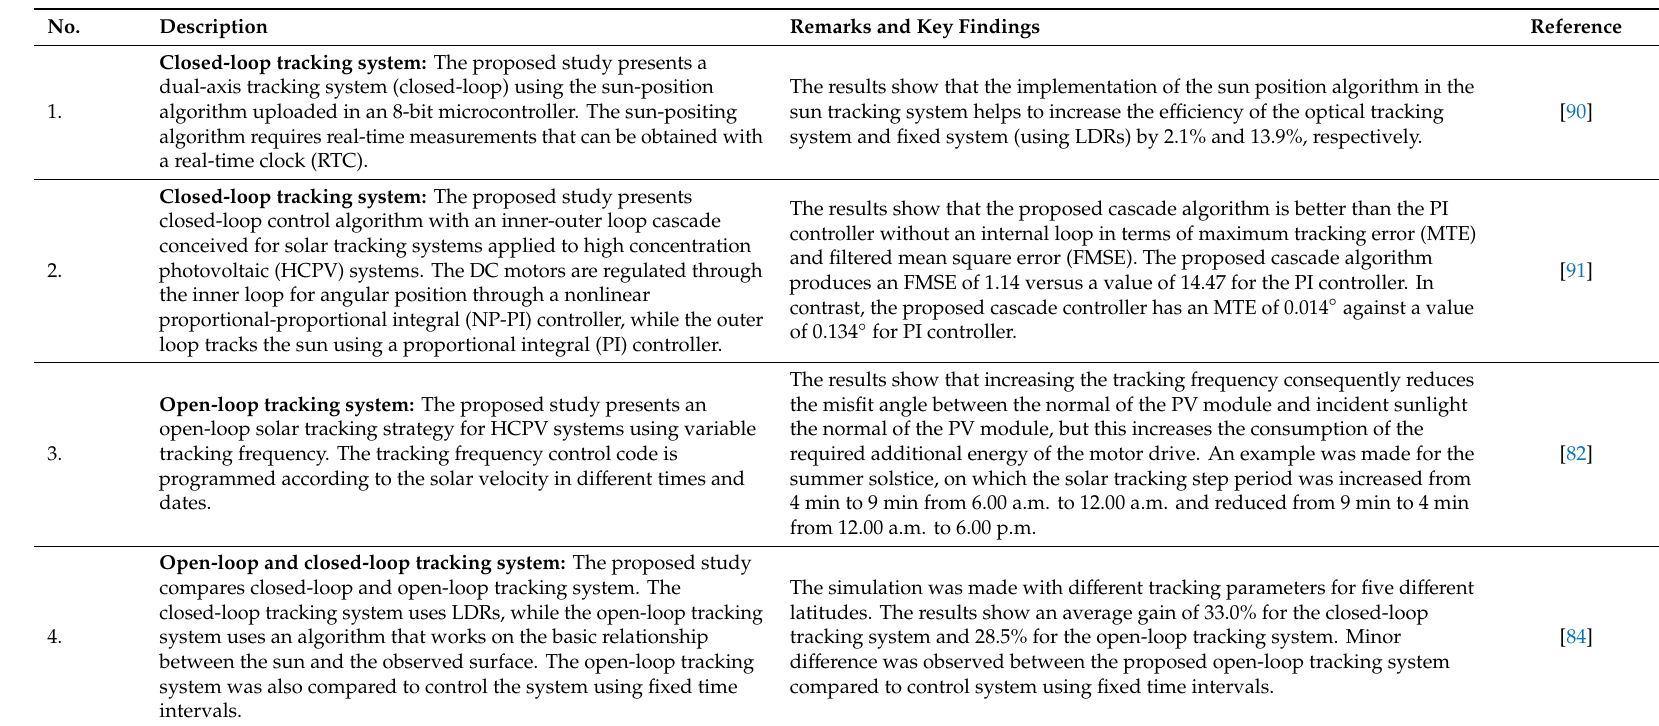
Table 2. Summary of some important studies focusing on closed -loop, open-loop, and hybrid control tracking